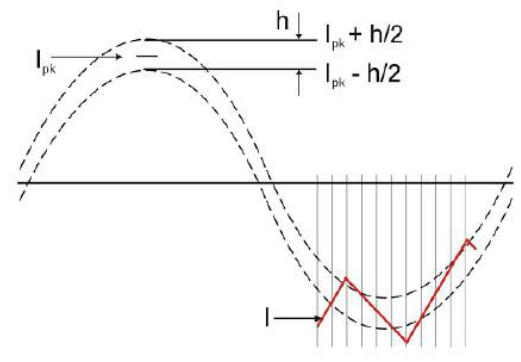
Fig. 4. Shape Wave Flow Control Hysteresis.